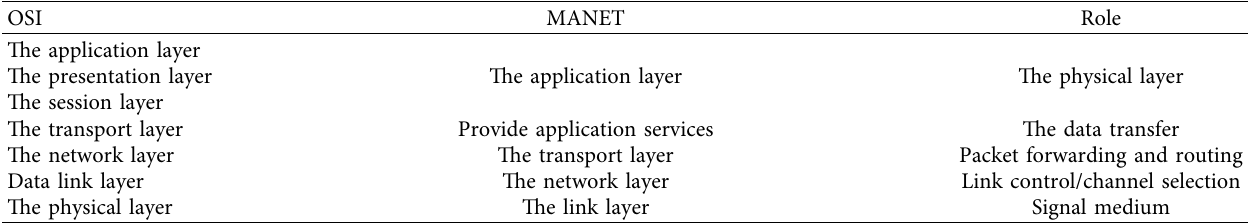
Table 1: The layers of